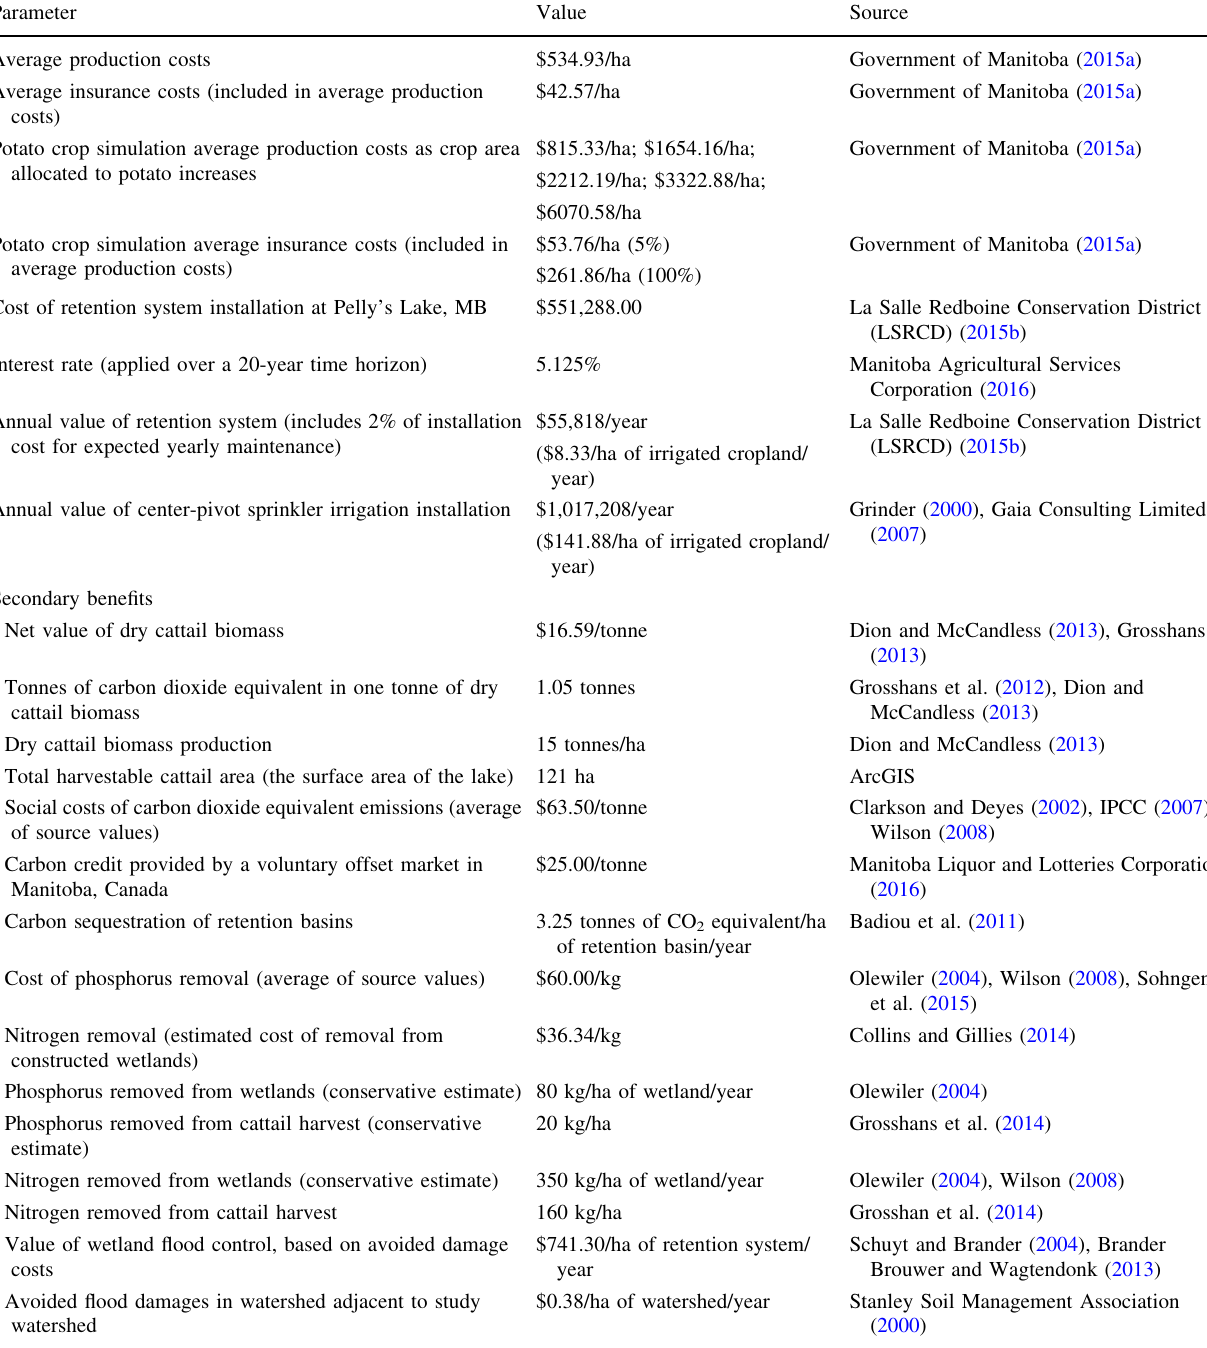
Table 1 Parameter values and sources for the economic